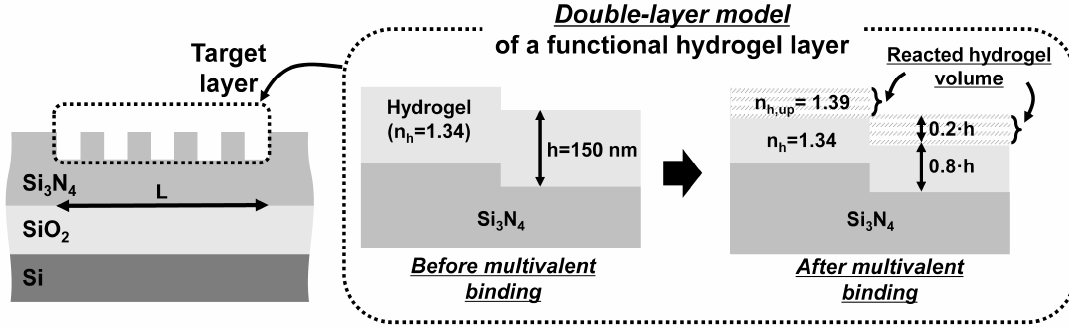
Figure 2. A silicon-based grating waveguide refractive index (RI) sensor and conceptual diagram showing the RI change of a functional hydrogel layer using a double-layer model [19,26]. The inset shows the shape of the hydrogel layer and grating waveguide that corresponds to a single tooth-groove period. L: grating length, h: hydrogel layer thickness, n h : RI of the hydrogel layer before the multivalent binding or RI of the non-reacted hydrogel volume after the multivalent binding, n h , up : RI of the reacted hydrogel volume after the multivalent binding .